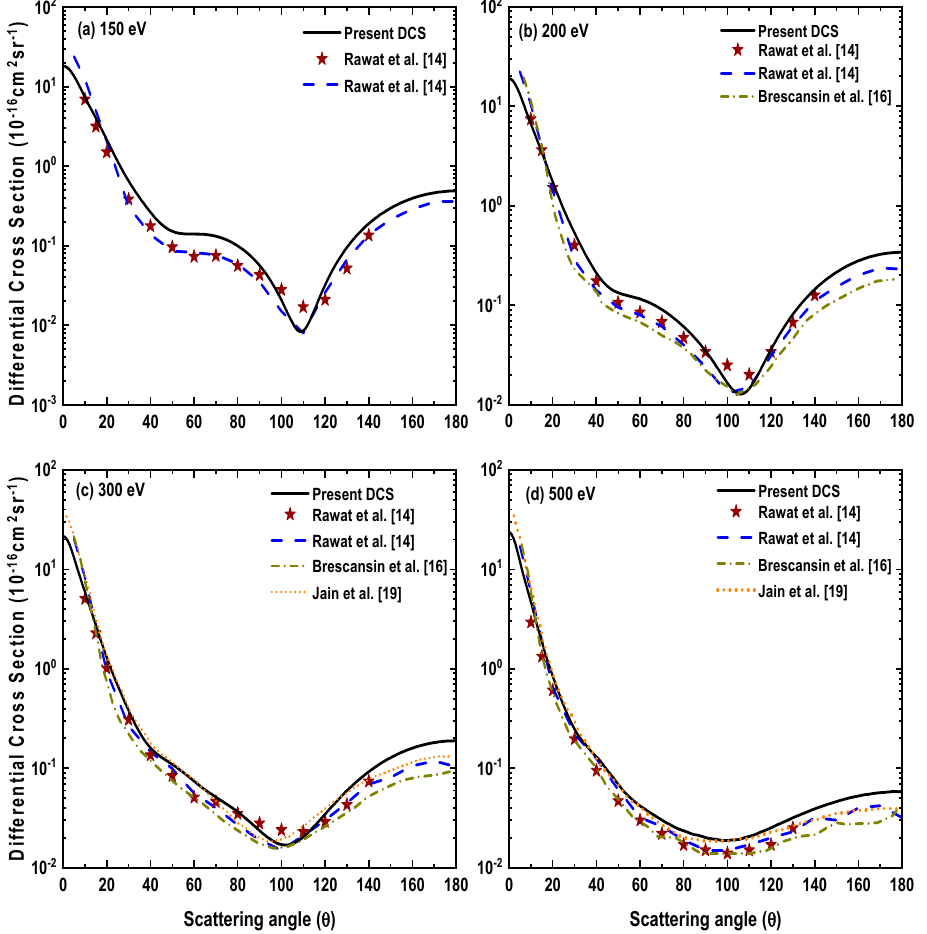
Figure 4. Di ff erential cross sections for electron − H 2 S scattering at incident electron energies ( a ) 150 eV, ( b ) 200 eV, ( c ) 300 eV and ( d ) 500 eV.